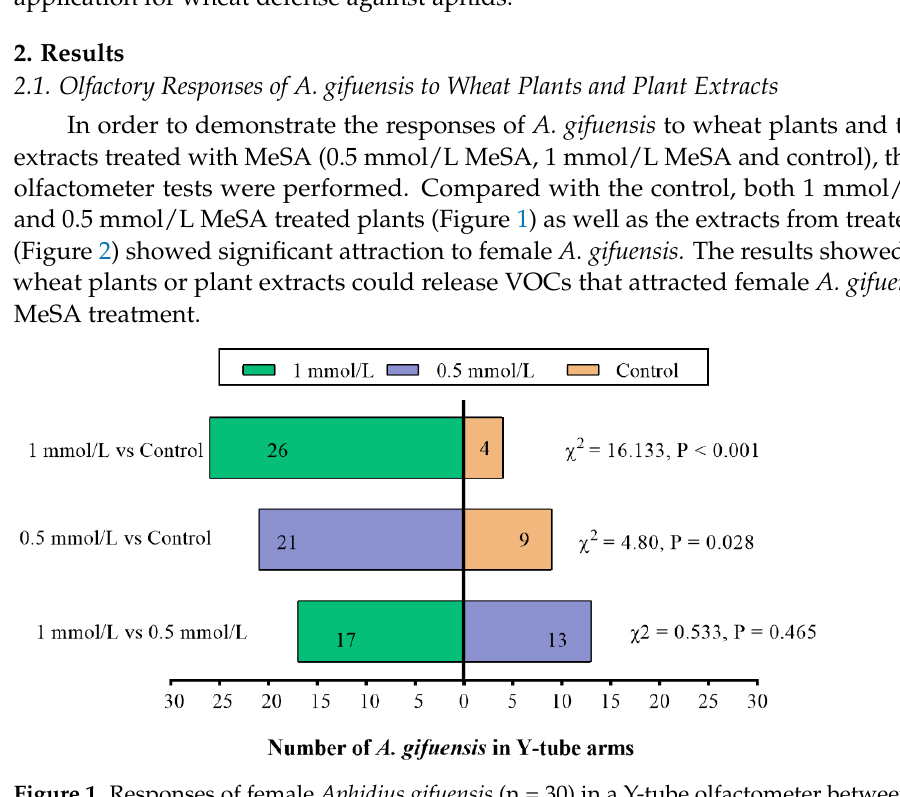
Figure 2. Responses of female Aphidius gifuensis (n = 30) in a Y-tube olfactometer between the arm with the untreated plant extracts and the arm treated with either 1 mmol/L MeSA or the 0.5 mmol/L MeSA plant extracts. 2.2. Analysis of Wheat Seedling Volatiles A total of 20 VOCs were detected in the volatile profiles of both untreated and treated plants (Table 1). The identified compounds were primarily alcohols, aldehydes, ketones, terpenes and alkanes. Qualitative differences were observed in volatile emission between untreated and treated plants. Among the 20 volatile compounds identified, 13 volatile compounds were identified induced by MeSA and seven volatile compounds were unique to 1 mmol/L: 2,5-Dimethyl-1-hepten-4-ol, p-Cymene, Carveol, Levomenthol, Lin- alool, Tetradecane and β -Acorenol. (Table 1). Eleven volatile compounds were selected from the identified volatiles and the rela- tive content changes of different treatments were analyzed at 24, 48 and 72 h (Table 2). The relative contents of 3-carene and 6-methyl-5-Hepten-2-one in 1 mmol/L MeSA treat- ment were significantly higher than that in 0.5 mmol/L MeSA treatment. Linalool, Carveol, m-Diethyl-benzene and Levomenthol were emitted only from the 1 mmol/L treatment. The emission of D-Limonene significantly increased at 24, 48 and 72 h com- pared with the control and the emission of MeSA at 72 h was significantly higher than that at 24 and 48 h.